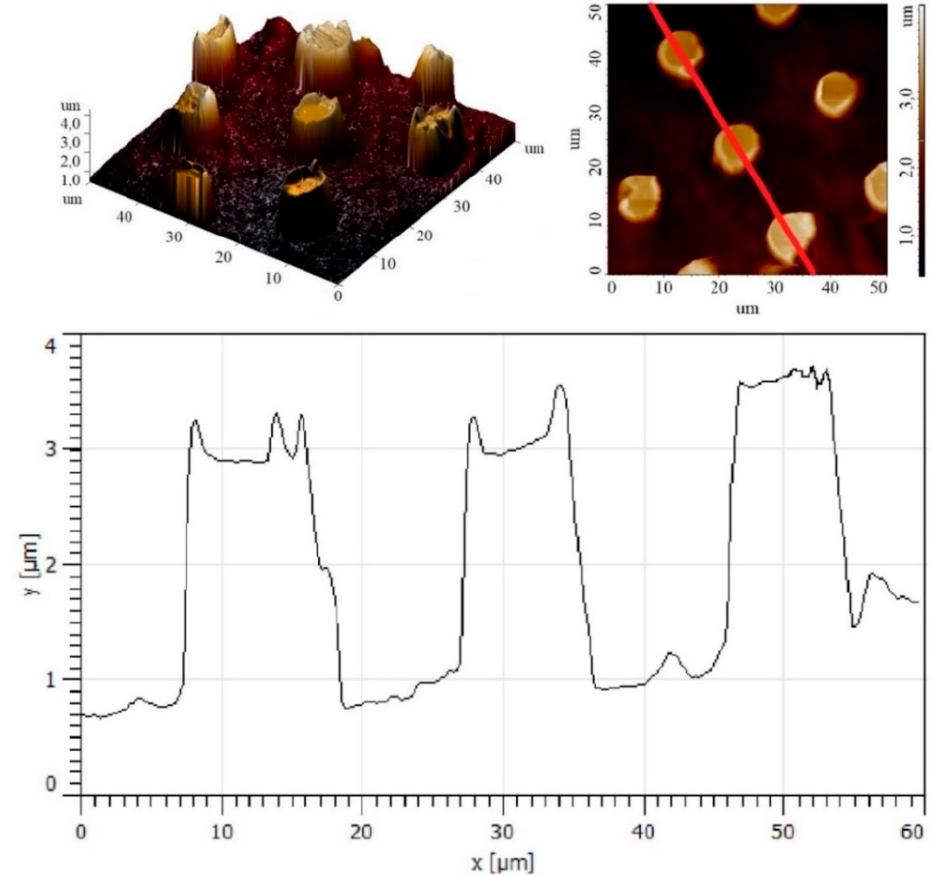
Figure 4. AFM topography of the imprinted PVDF micropillar array and a line scan profile along the line shown on the two-dimensional (2D) topography image.